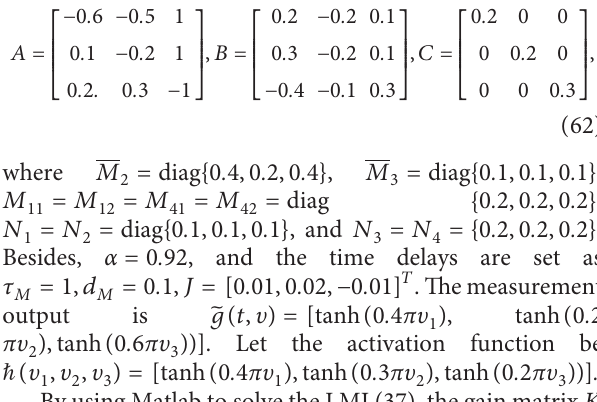
Figure 4: The estimation